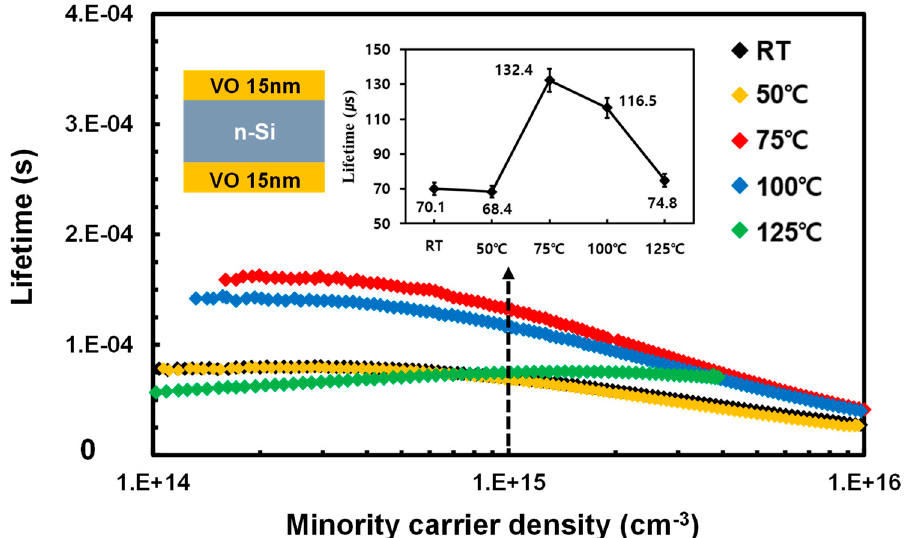
Figure 2. Minority carrier lifetimes plotted against the minority carrier density. Carrier lifetimes were measured at different V 2 O 5 − x deposition temperatures for the cell structure in the inset. (Note: The vertical black dashed arrow indicates the carrier injection level of 1.5 × 10 15 cm − 3 at which the τ ef f values in the inset were derived). As shown in Figure 2, the 𝜏 (cid:3032)(cid:3033)(cid:3033) values of the samples measured at RT and 50 °C were